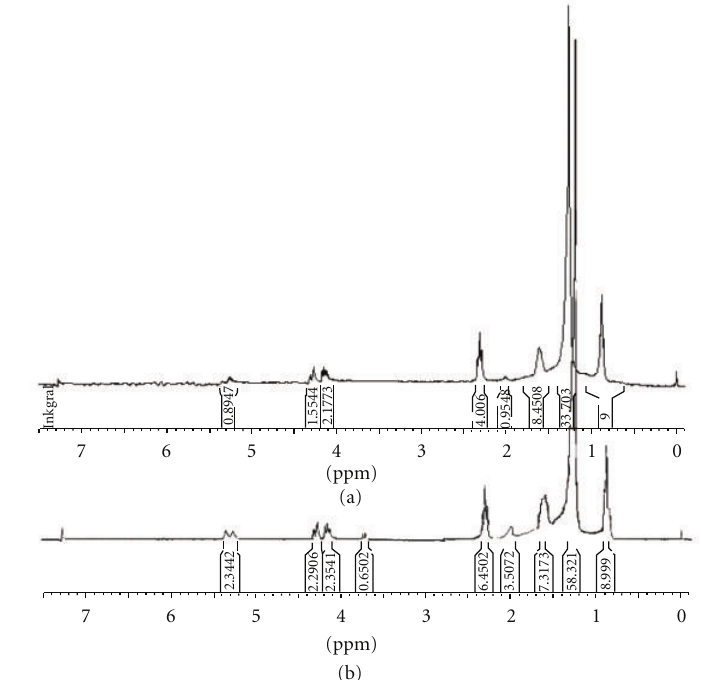
Figure 1: 1 H NMR spectra of indai´a oil (a) and of babassu oil (b) in CDCl 3 .